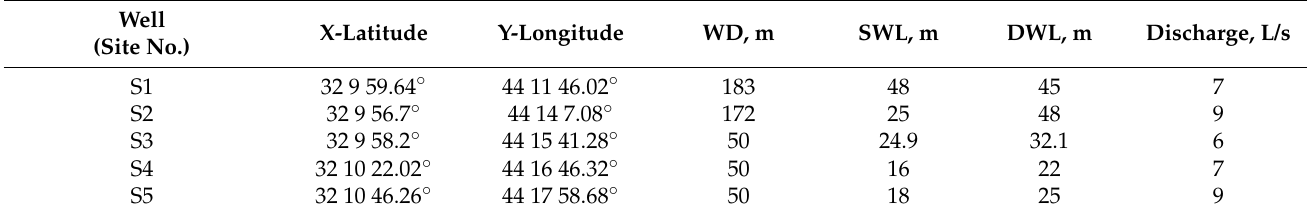
Table 1. Coordinates of the groundwater-sampling sites by GPS (Garmin navigator).